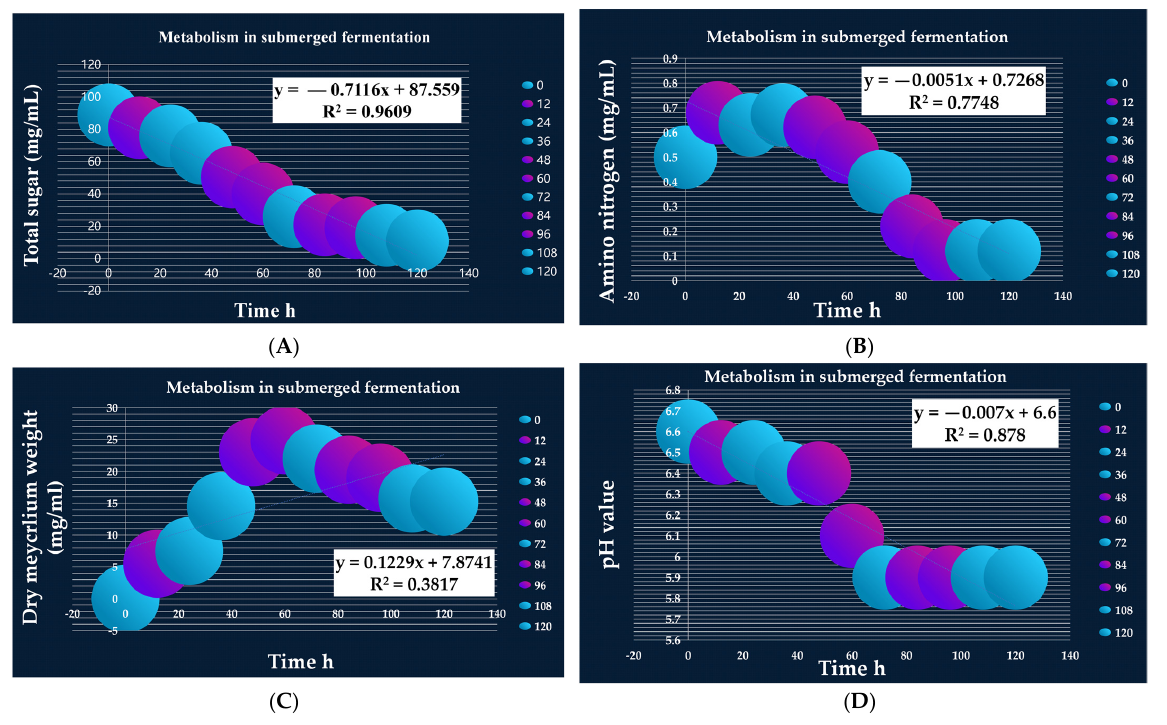
Figure 3. Metabolism study of submerged fermentation batch of B. velezensis BP-1. Total sugar consumption ( A ), amino nitrogen production ( B ), dry mycelium weight ( C ), and pH values ( D ). The correlation between the parameters regarding metabolism with culturing time. In order to analyze the data, all treatments were repeated three times.